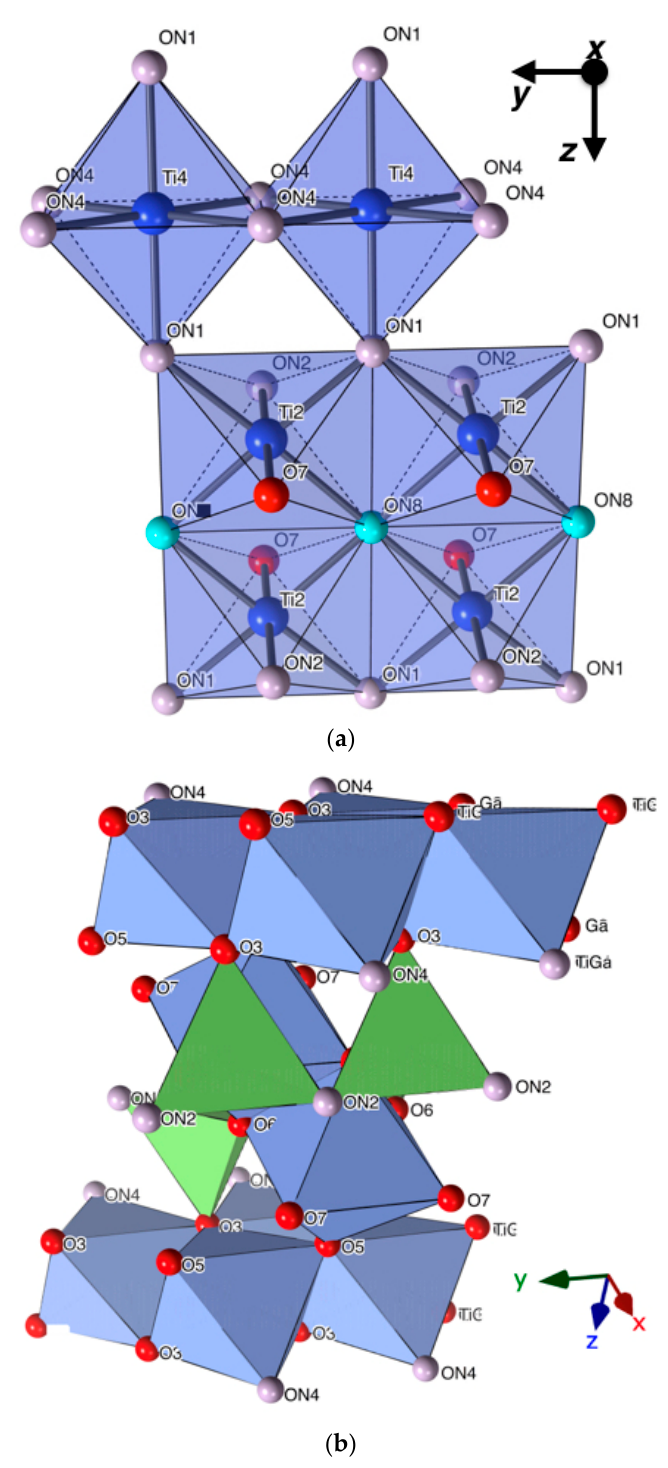
Figure A1. ( a ) top—Ti-block and ( b ) bottom—Ga-Ti block (see Figure 3). Refined U iso × 10 2 Å 2 = 0.67(1) and 0.41(2) for cation and anion sites, respectively. Refined Composition: Ti 8 Ga 10 O 28 N 2 or Ti 4 Ga 5 O 14 N. Unit cell: monoclinic, C 2/ m, a = 17.823(1) Å, b = 2.9970(1) Å, c = 9.4205(5) Å, β = 98.446(3)°; Volume = 497.74(3) Å 3 . Refinement statistics: combined R wp = 5.57% GOF = 3.69 for joint X-ray neutron data (R wp = for the individual X-ray and Neutron data sets were R X wp = 13.31% (38,714 observations) and R N wp = 2.15% (4035 observations) respectively; the X-ray:neutron data were weighted 1:1.5; the integrated Bragg